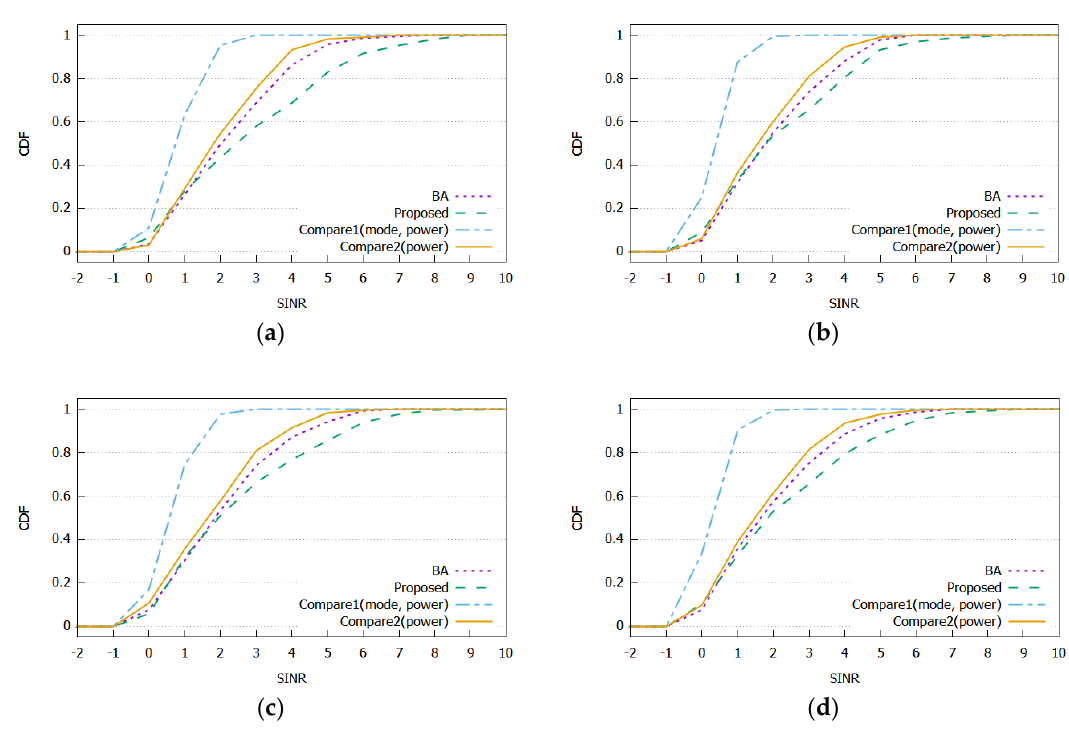
Figure 5. Comparison of signal-to-interference noise ratio (SINR) with various D2D distances and system loads: ( a ) 250 m with light traffic; ( b ) 350 m with light traffic; ( c ) 250 m with heavy traffic; and ( d ) 350 m with heavy traffic.